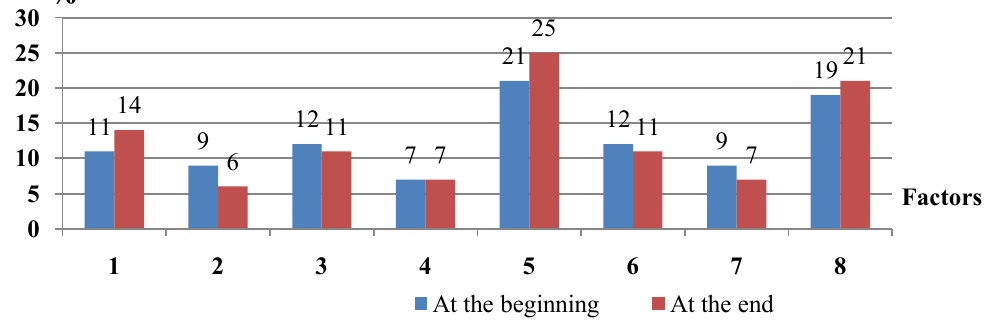
Fig7. Factors of school anxiety of girls with straightened postures during academic year (n=12): 1-8